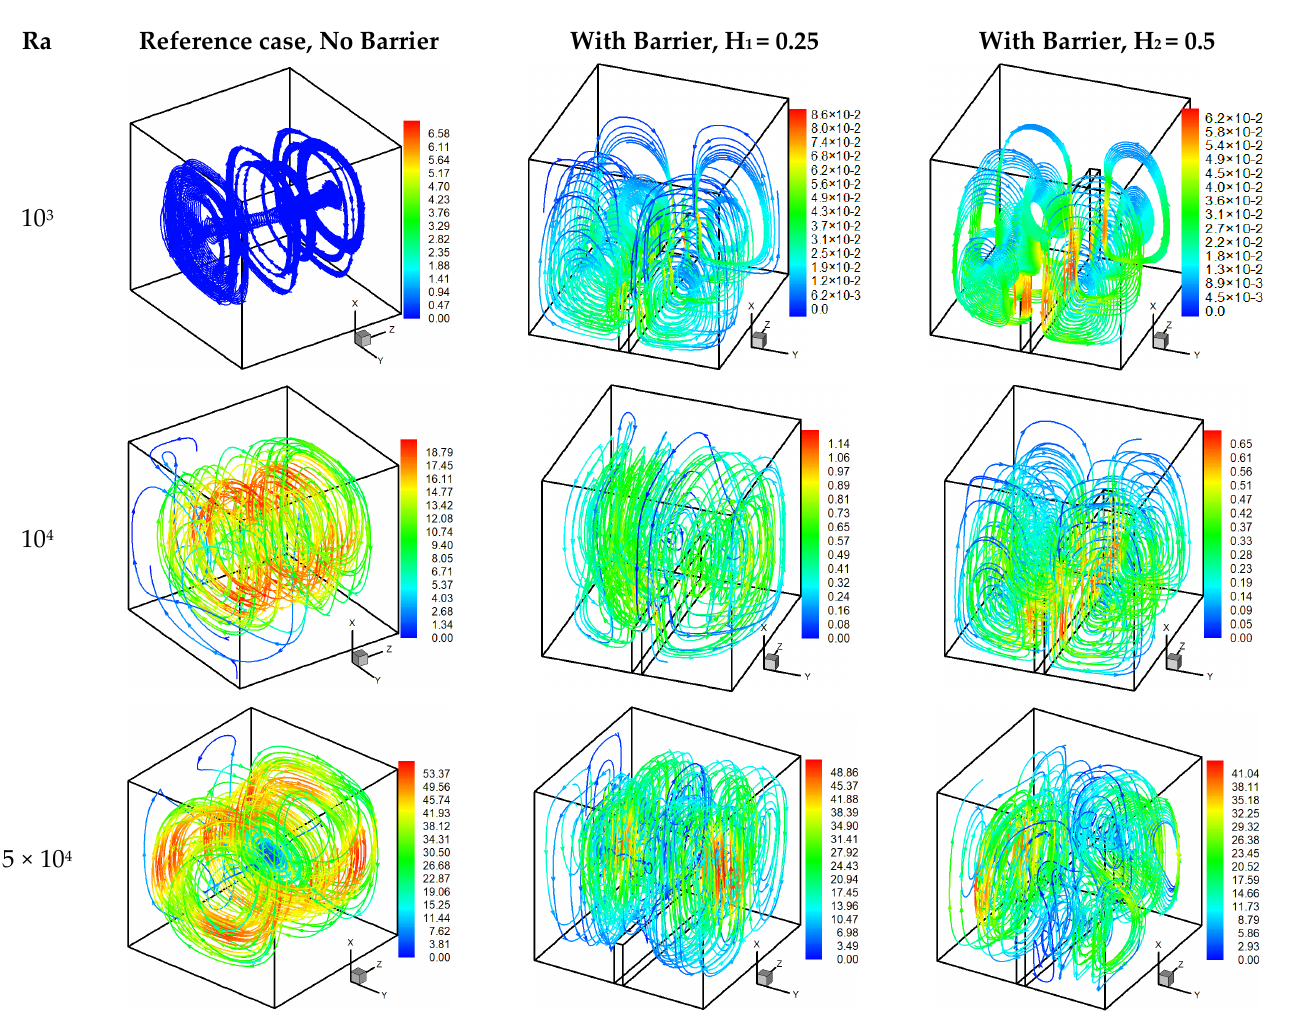
Figure 5. Particles’ trajectories of the fluid in the building for different Ra, effect of two barriers’ heights for N = 0.